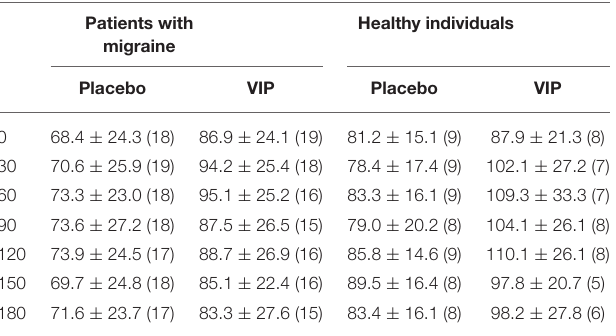
Healthy individuals